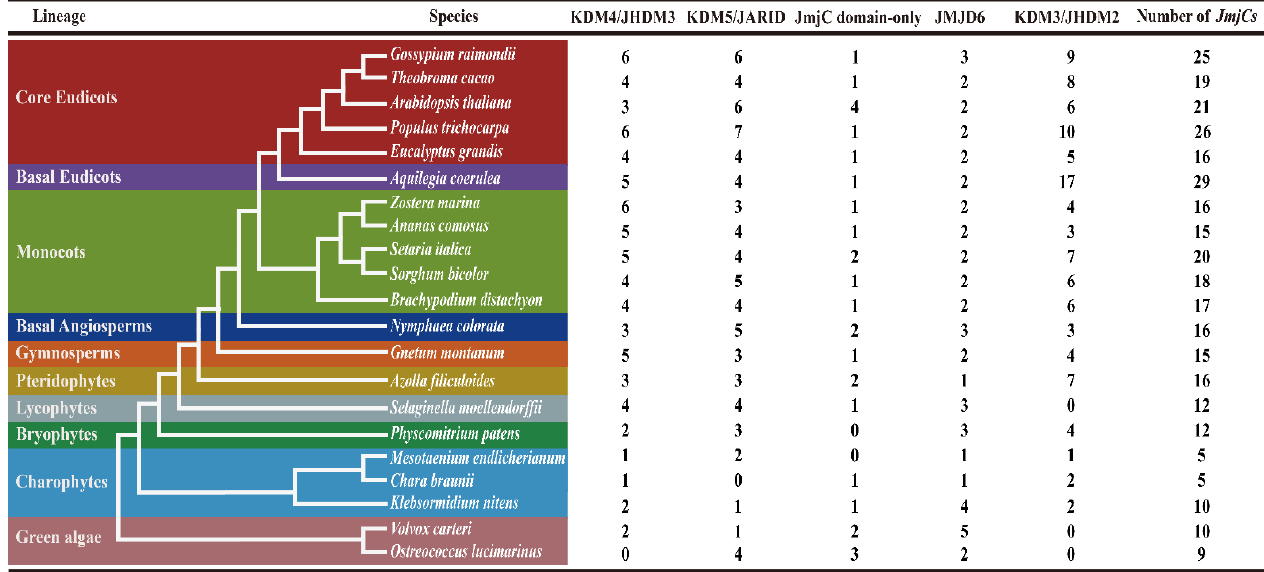
Figure 1. Phylogenetic relationships among 21 species. Different background colors in the phyloge- netic tree show different pedigrees. The right side shows the number of JmjC genes in each species of the different subfamilies and the total number of JmjC genes found in the genome of each species.